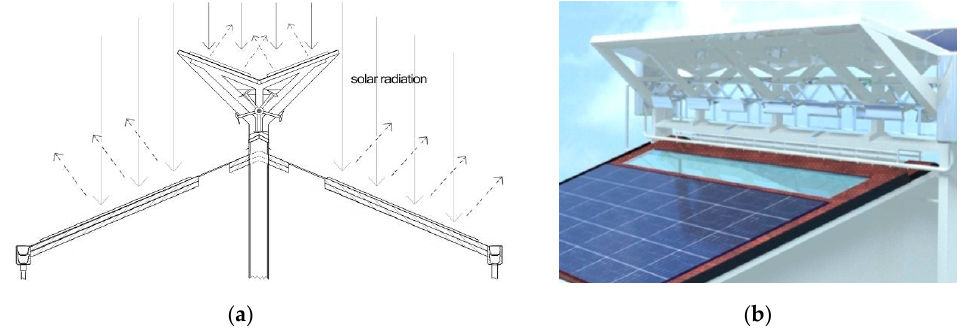
Figure 8. Daylight harvesting system diagrams: ( a ) Schematic diagram; ( b ) skylight windows.